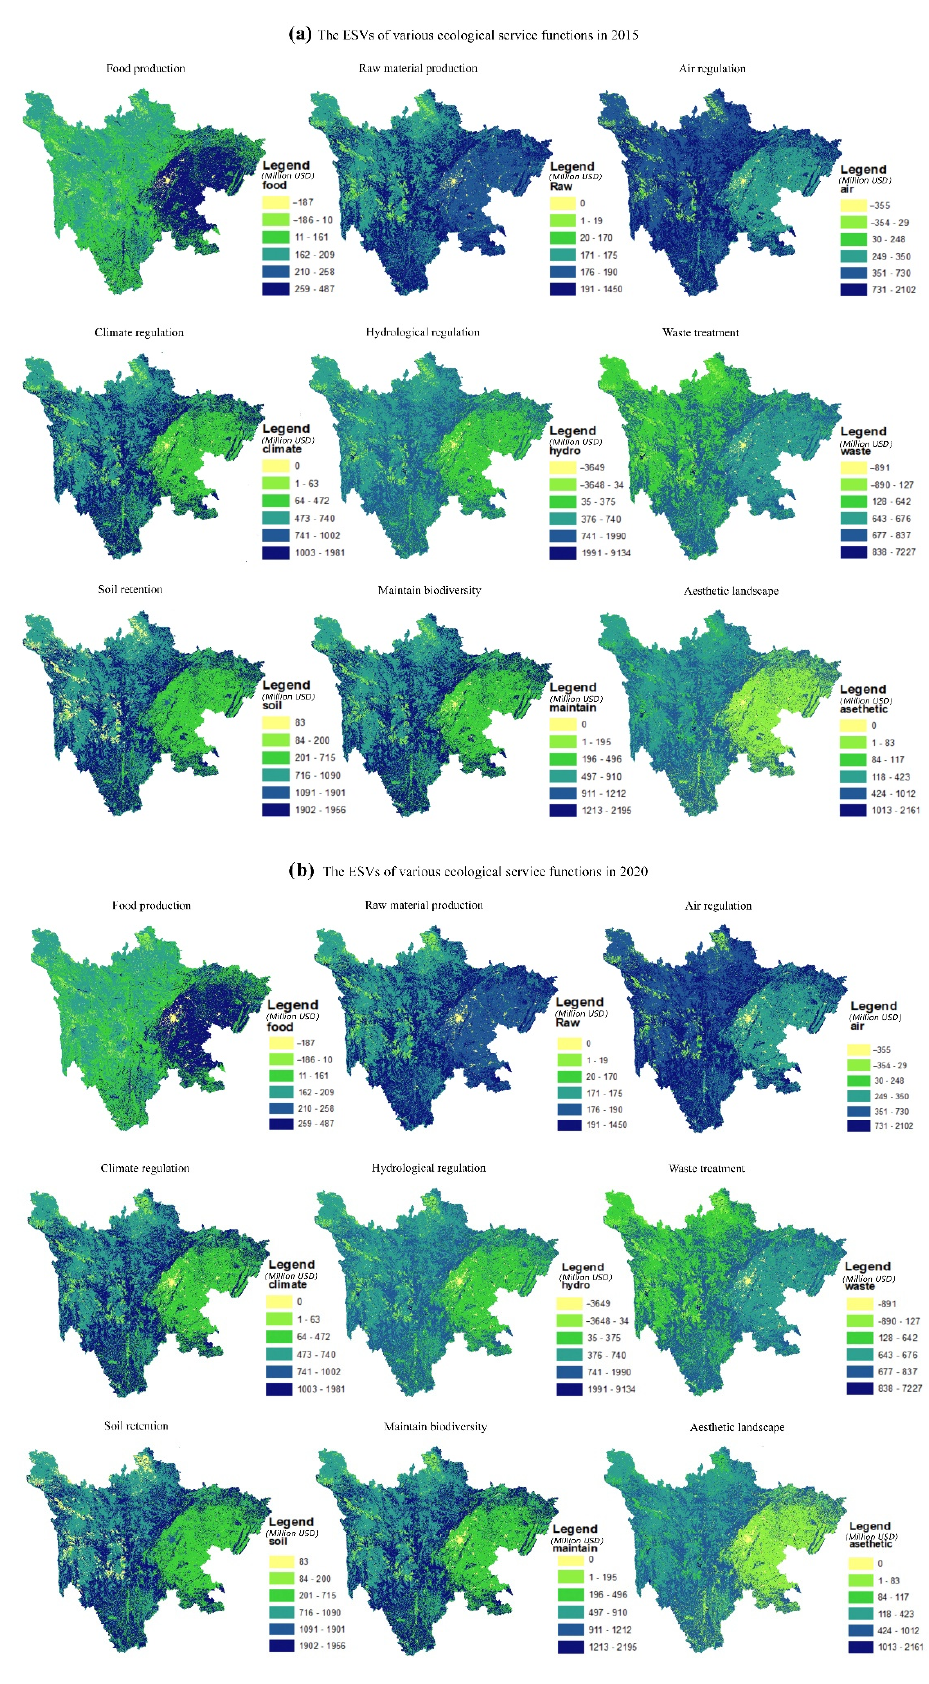
Figure 7. The spatial distribution of the nine types of ecological service functions value in 2015 and 2020.